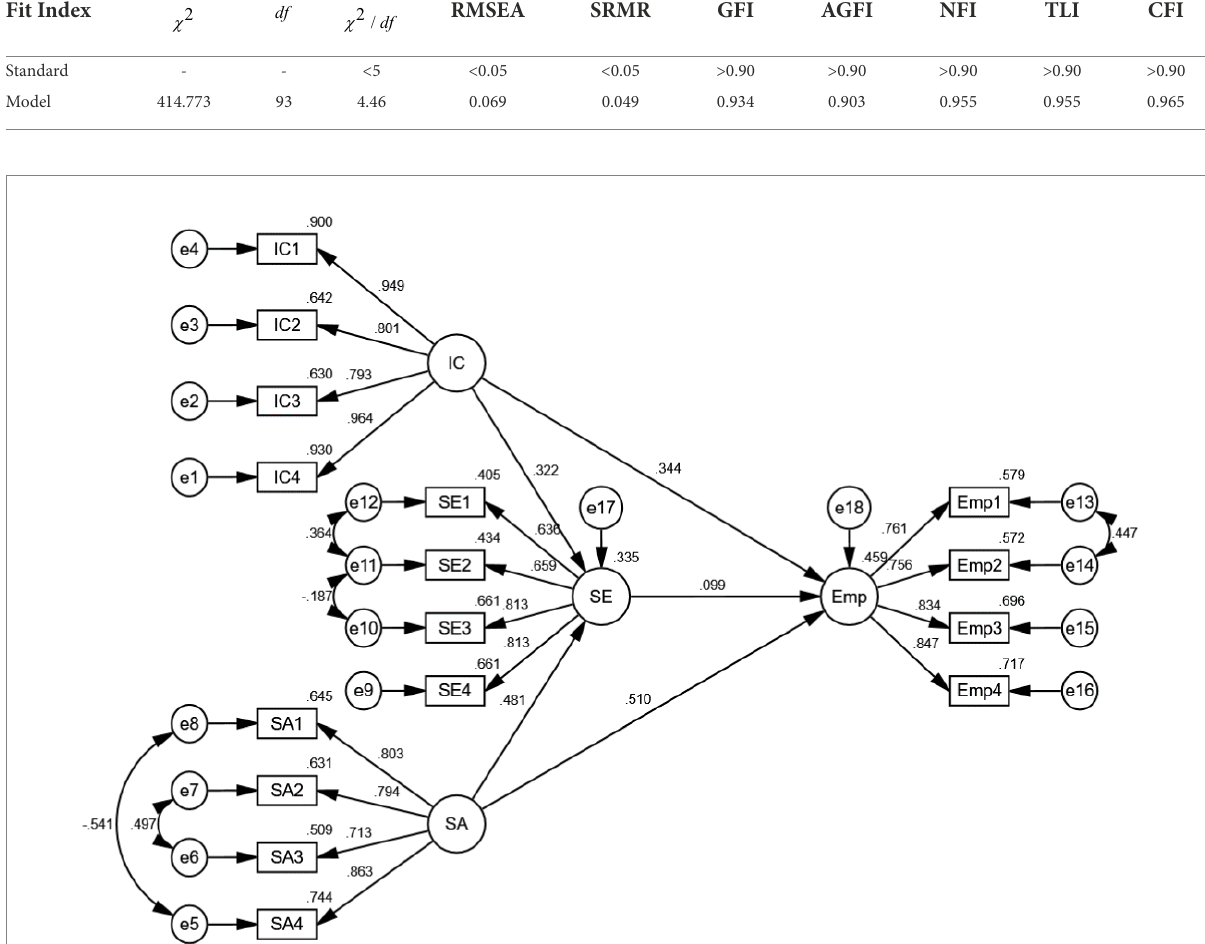
FIGURE 2 Result of the path analysis. IC, innovation capability; SA, social adaptability; SE, self-efficacy; Emp,